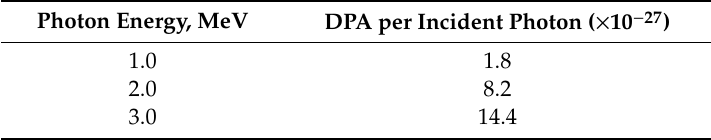
Table 4. Radiation damage due to photon irradiation of the CLYC crystal.